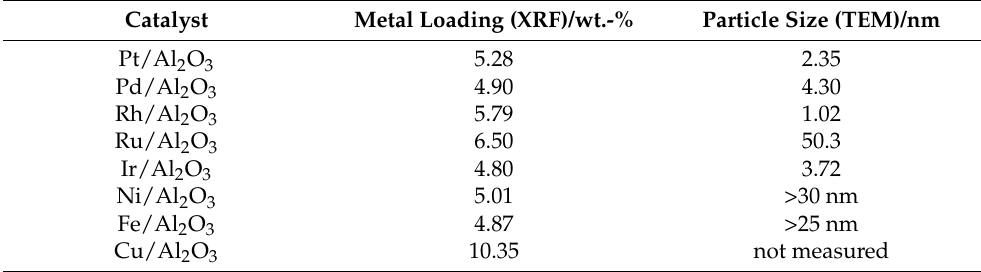
Table 1. Characterization results (XRD and TEM) for the prepared